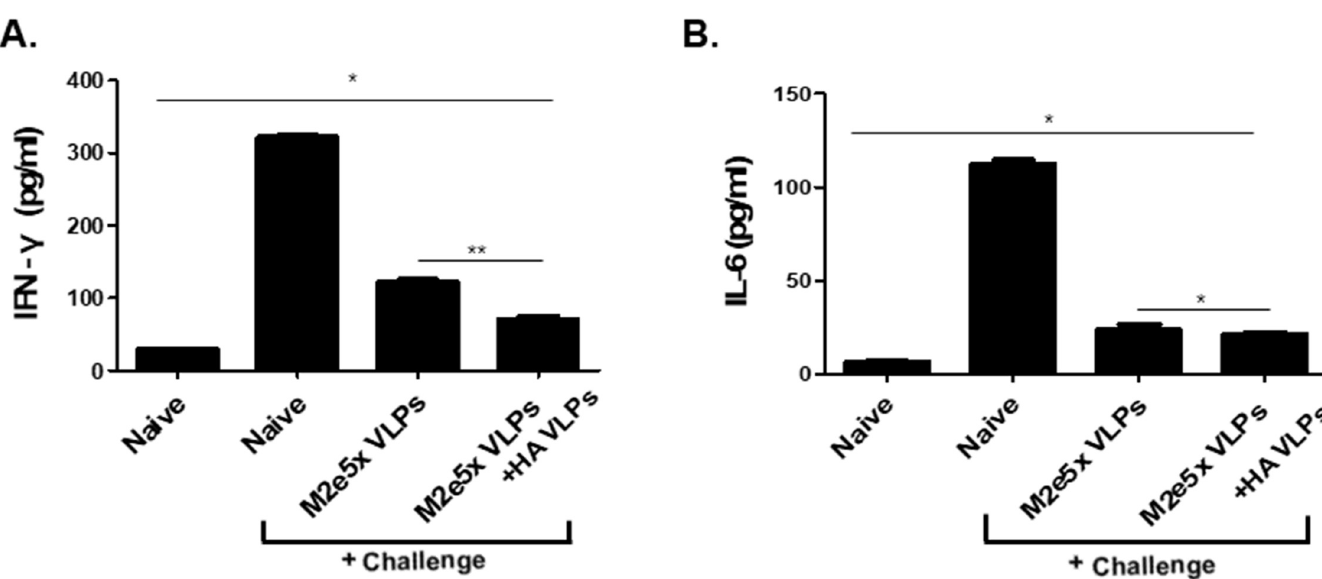
Fig 6. Inflammatory responses. Levels of inflammatory cytokines IFN- γ (A) and IL-6 (B) were also determined in the lung extracts at day 4 after challenge with A/Viet Nam/1203/2004 (rgH5N1) virus. Combinatorial group showed significantly lower levels of IFN- γ compared to M2e5x VLPs alone group and Na ï ve + Challenge group ( � P < 0.05). Data are expressed as mean ± SD.